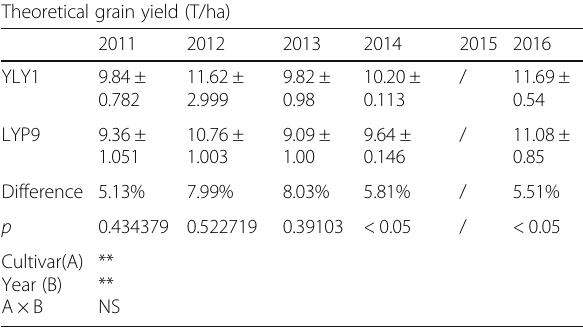
Table 8 Theoretical grain yield for 2013 to2016 Experiments were conducted in three plots. Grain yields from 50 hills were measured and used to estimate the theoretical yield. n = 3, the grain yield of 2011, 2012 according the grain weight of 10 hills, “ *, ” “ ** ” represent significance levels of p = 0.05 and p =